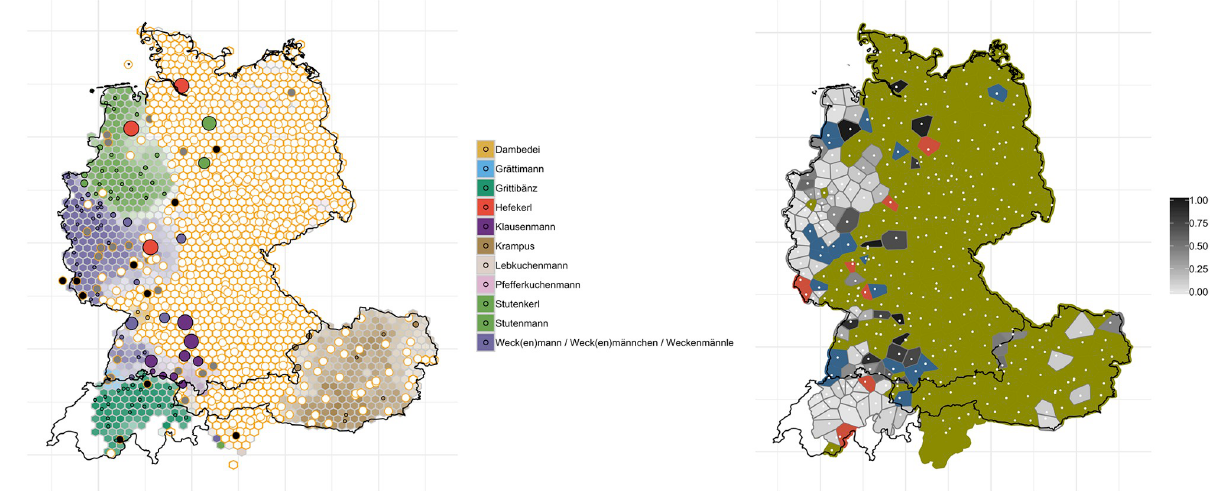
Fig 7. Variant and degree of change maps for